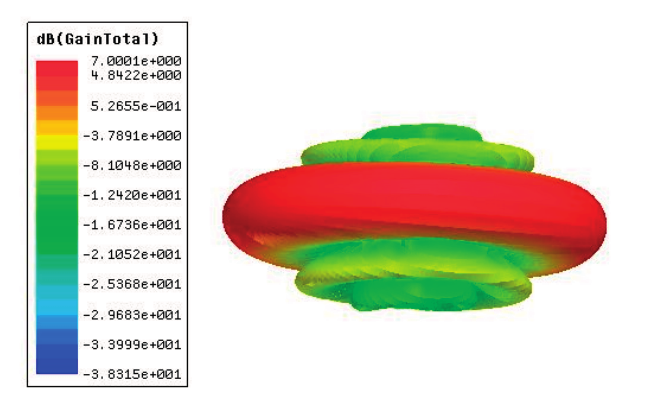
Figure 10. Simulation result showing the side view of the radiation beam